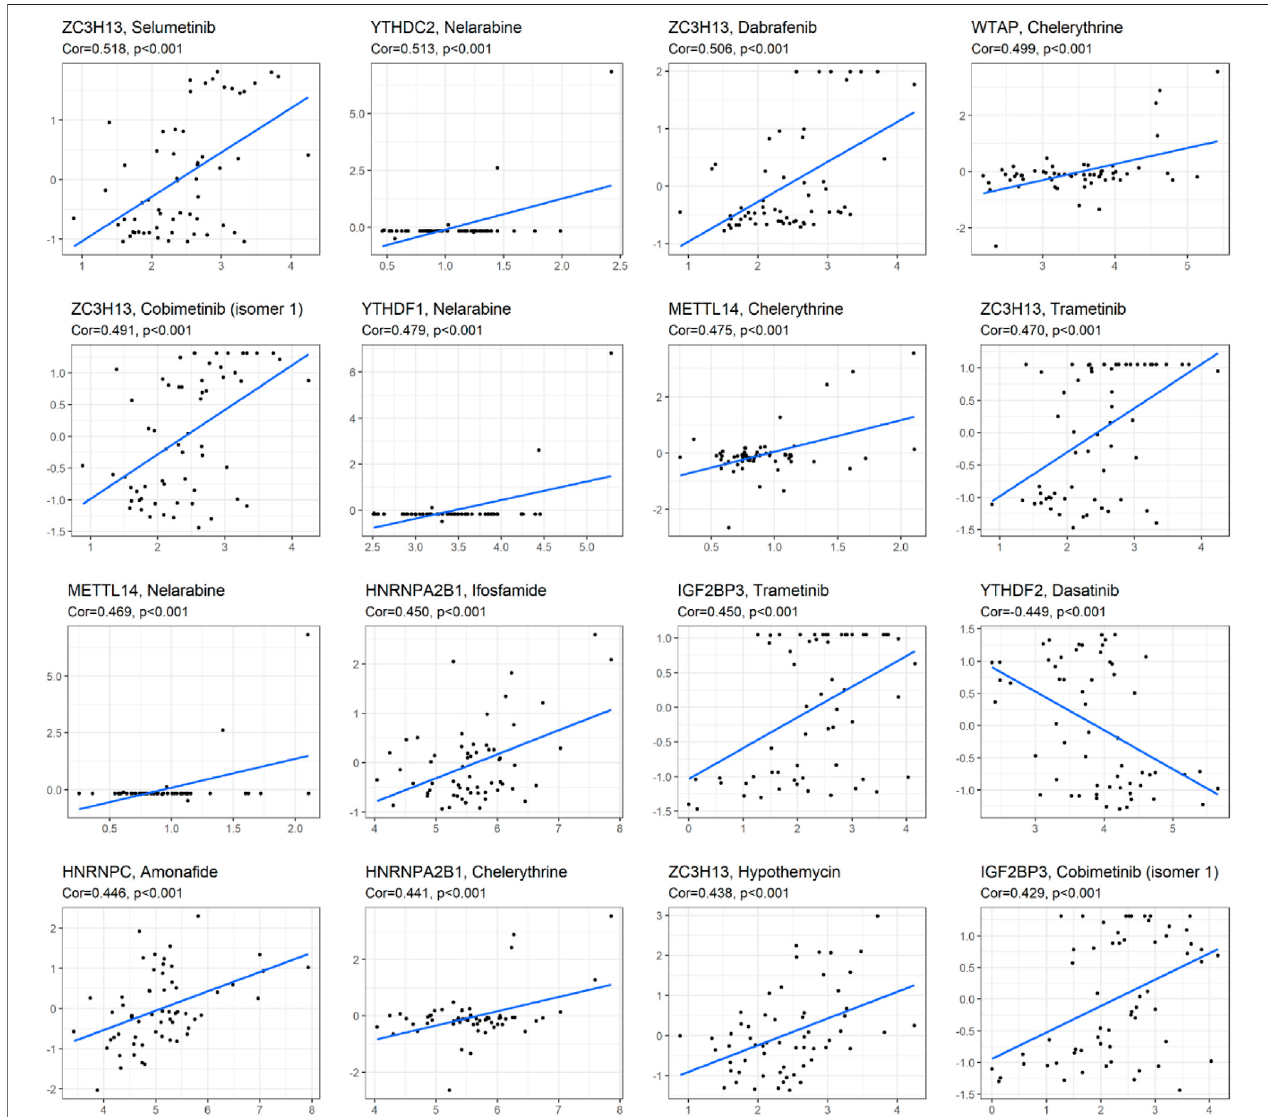
FIGURE 7 | Correlation analysis between m6A methylation regulators and drug sensitivity of anticancer drugs in CellMiner. The top 16 statistical signi fi cance correlation relationship between m6A methylation regulators and drug sensitivity of anticancer drugs.